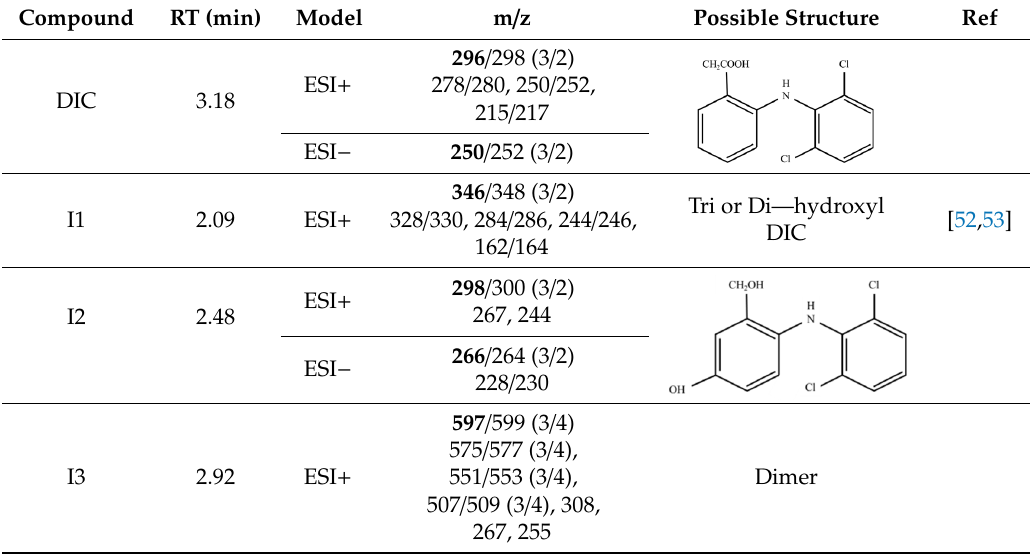
Table 2. MS data of intermediate and final products.